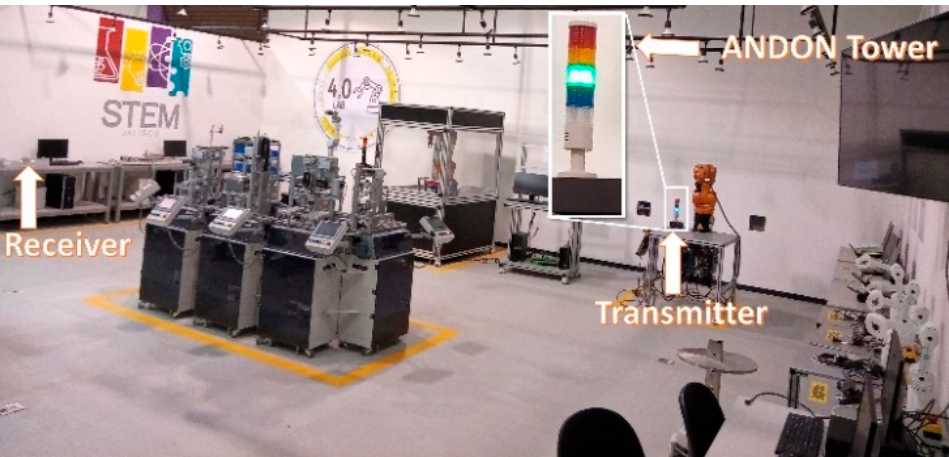
Figure 1. Experimental scenario, workshop TecMM, Zapopan, México.